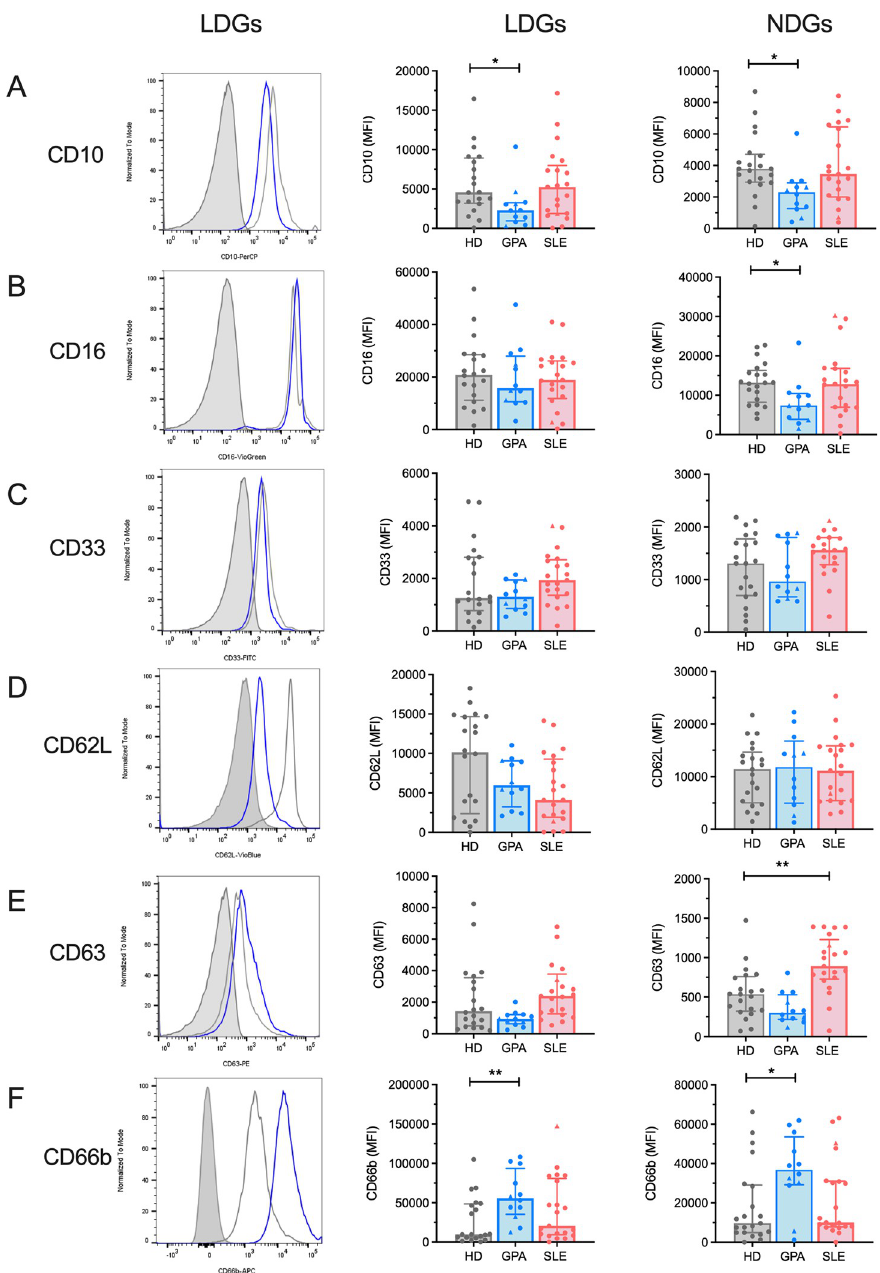
Fig 2. Phenotypic analysis of LDGs and NDGs. Surface markers associated with (A,C) maturity (CD10, CD33), (B,F) activation (CD16, CD66b), (D) adhesion (CD62L) and (E) degranulation (CD63) were measured on LDGs and NDGs (HD, n = 21; GPA, n = 12; SLE, n = 21) by flow cytometry. Pateints receiving prednisolone dosages of � 20mg daily (3 patients with GPA and one patient with SLE) are indicated by triangles. Representative histograms of LDGs with respective FMO control stainings (grey filled curve) for a healthy donor (grey line) and a GPA patient (blue line) are shown. Each dot represents one measured patient sample. Median values ± IQR are presented. Data were analysed by the Kruskal-Wallis-test ( α = 0.05), � p < 0.05, �� p < 0.01.